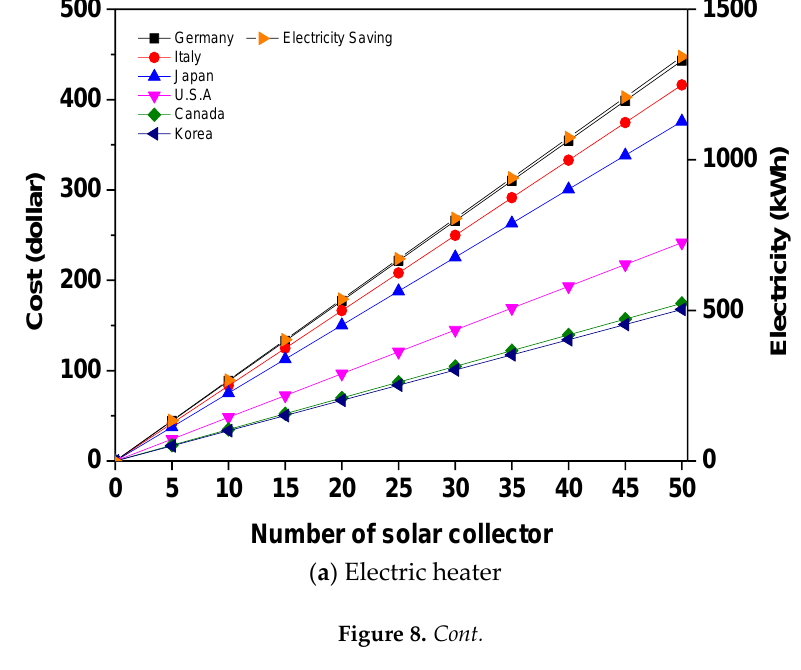
Figure 7. Electricity and electricity cost of the electric heater and heat pump using a flat-plate solar collector: ( a ) Electric heater; ( b ) Heat pump.